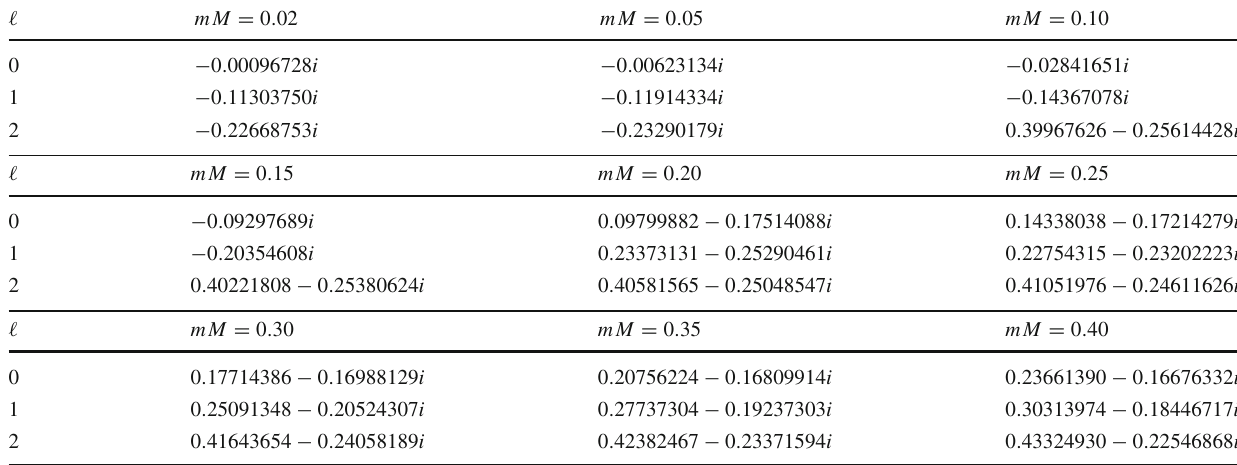
Table 3 Fundamental dS modes ( n dS = 0) for massive scalar fields with (cid:5) = 0 , 1 , 2 in the background of black hole solution of f ( R ) gravity with M 2 (cid:6) = 0 . 04, and M β = 0 .